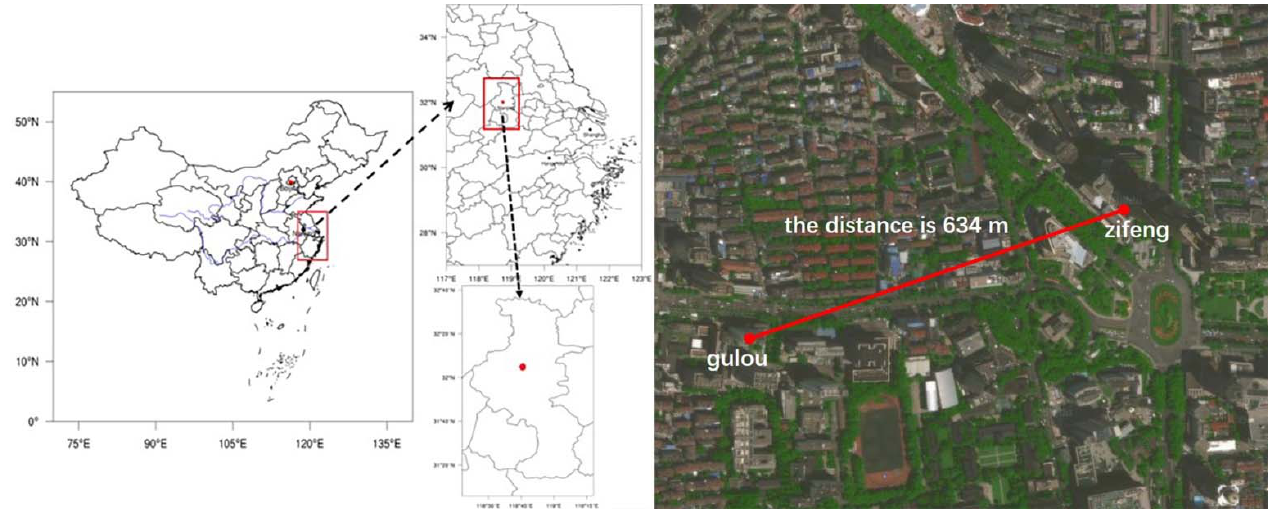
Figure 1. The locations of sampling sites.